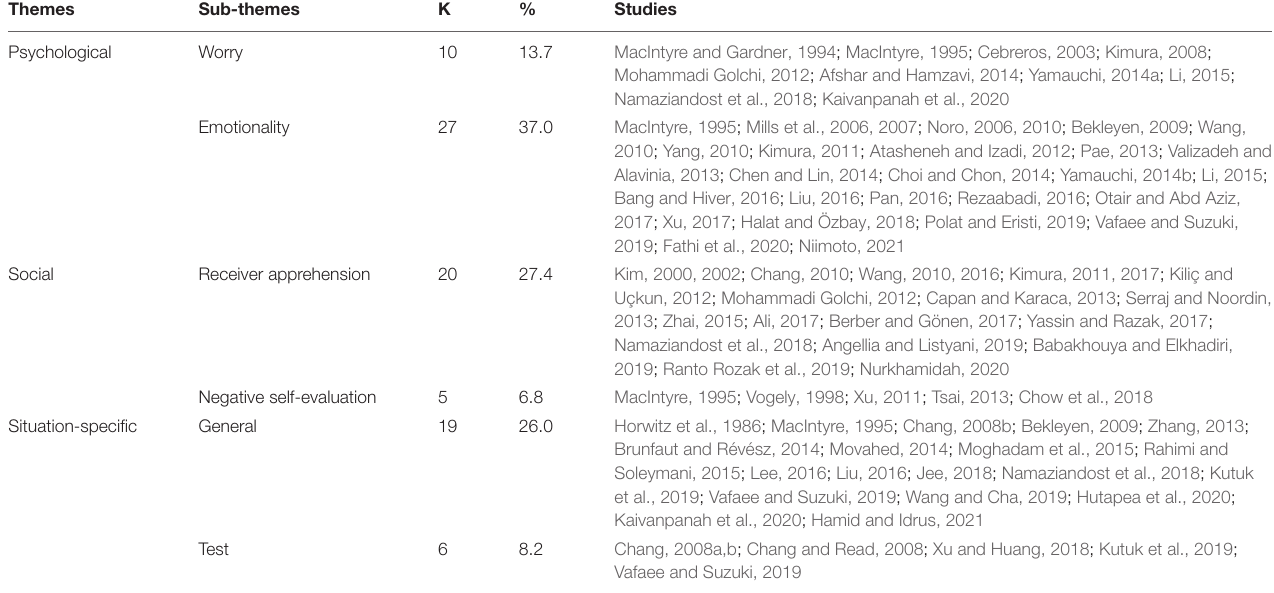
TABLE 2 | Domains of FL listening